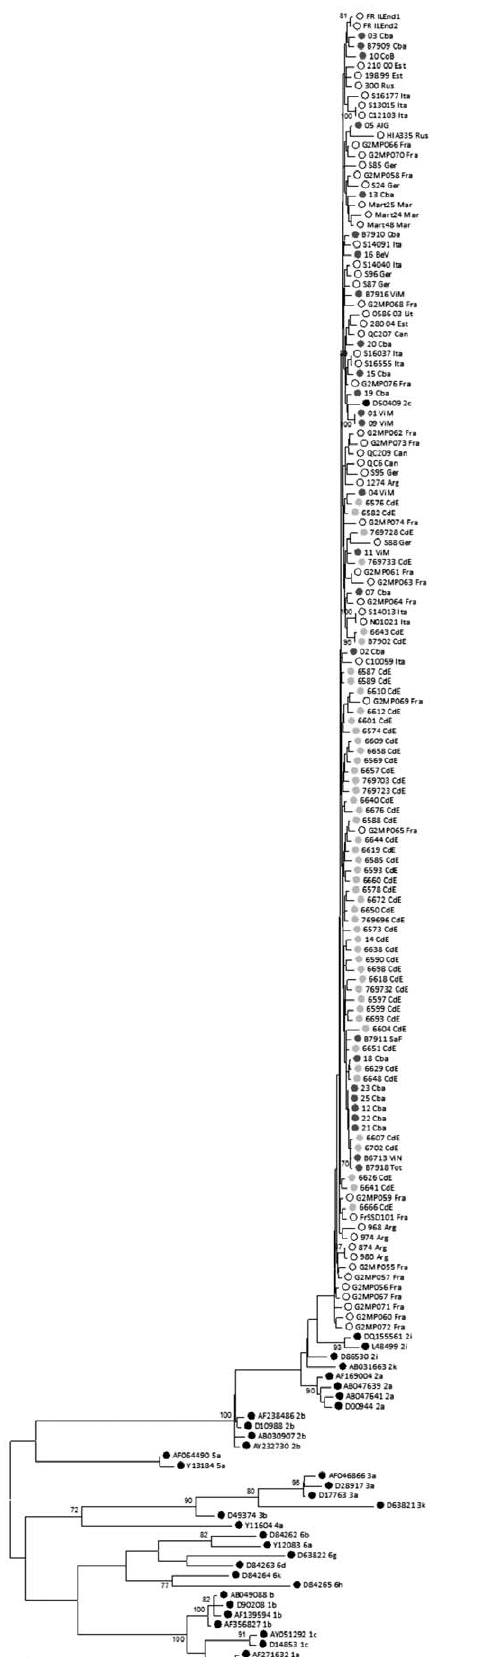
Figure 1. Maximum likelihood tree for the NS5B region constructed using TVM + Gamma + I as model of nucleotide substitution with parameters suggested by ModelTest 3.7 (PhyML software). Black bullets : Sequences from the Genotype Reference dataset; Hollow bullets : Sequences from the HCV-2c dataset. Light gray bullets : Sequences from the CdE data set. Dark gray bullets : Sequences from the OLC data set, Numbers above branches : bootstrap values over 100 pseudoreplica. Scale bar represents substitution per site.